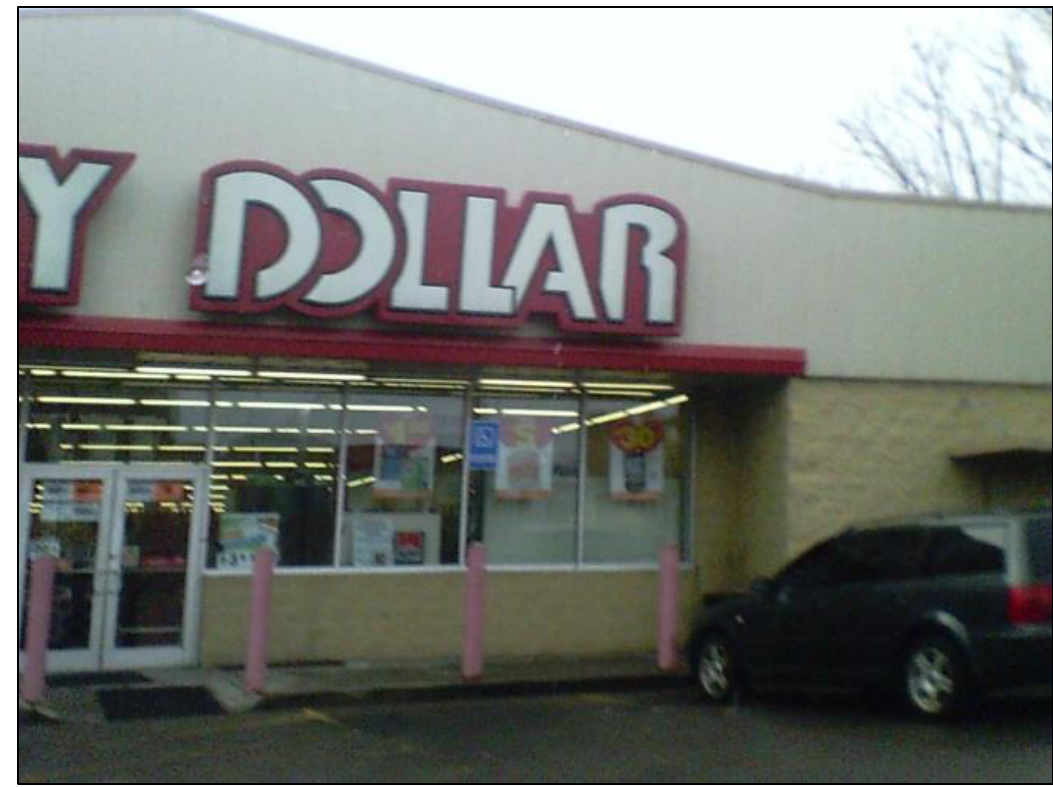
Figure 1. Photo caption: foods all about it; Health topic: body; “I go to Family Dollar